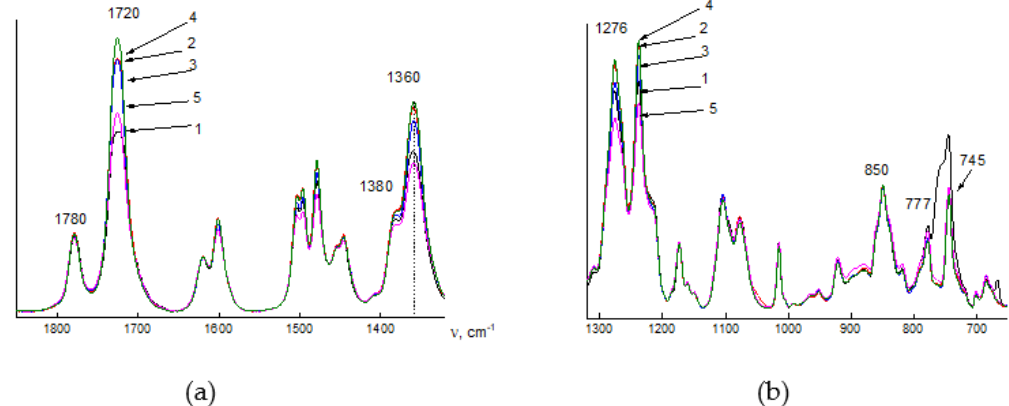
Figure 3. Fragments of the IR spectra of Ultem films in the region of absorption of stretching vibrations of imide and aromatic cycles ( a ) and the region of absorption of vibrations of C-O bonds, normalized to the absorption band at 850 cm − 1 ( b ): 1 —a film formed from CHCl 3 (as cast); 2 —as-cast film after ethanol treatment; 3 —as-cast film after sc -CO 2 treatment; 4 —as-cast film after stepwise annealing; 5 —as-cast film after stepwise annealing and sc -CO 2 treatment.